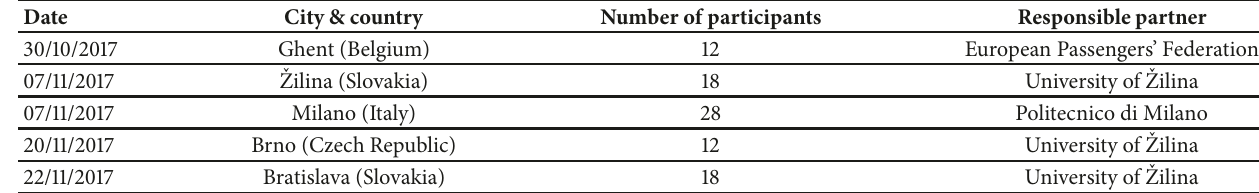
Table 2: Overview of the